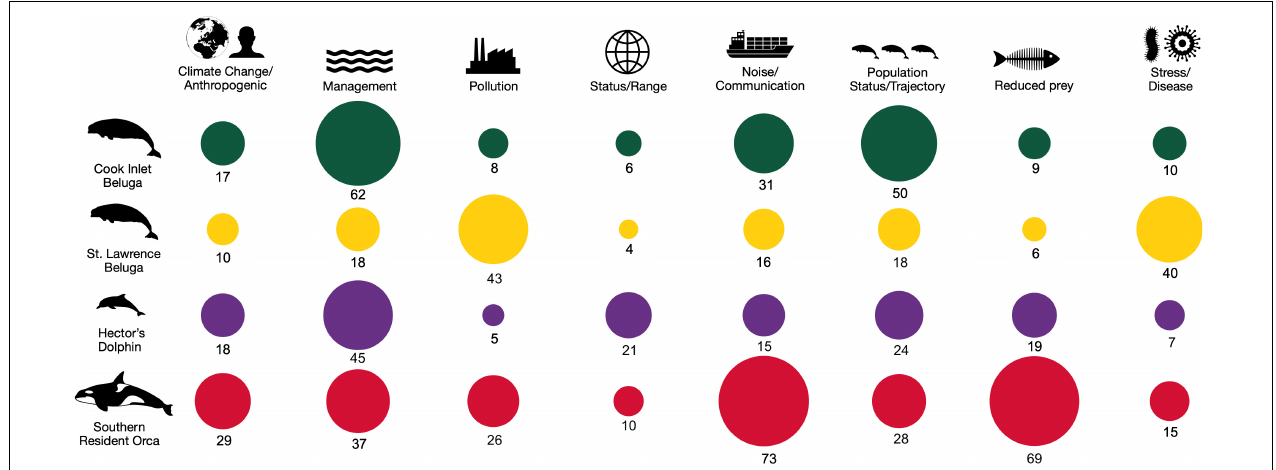
FIGURE 5 | Proportional distribution of records by threat/search term group for Cook Inlet belugas, St. Lawrence belugas, Hector’s dolphins, and southern resident killer whales, by search term category (x-axis) for each population (1975-May 2021). The numbers of articles are shown as raw